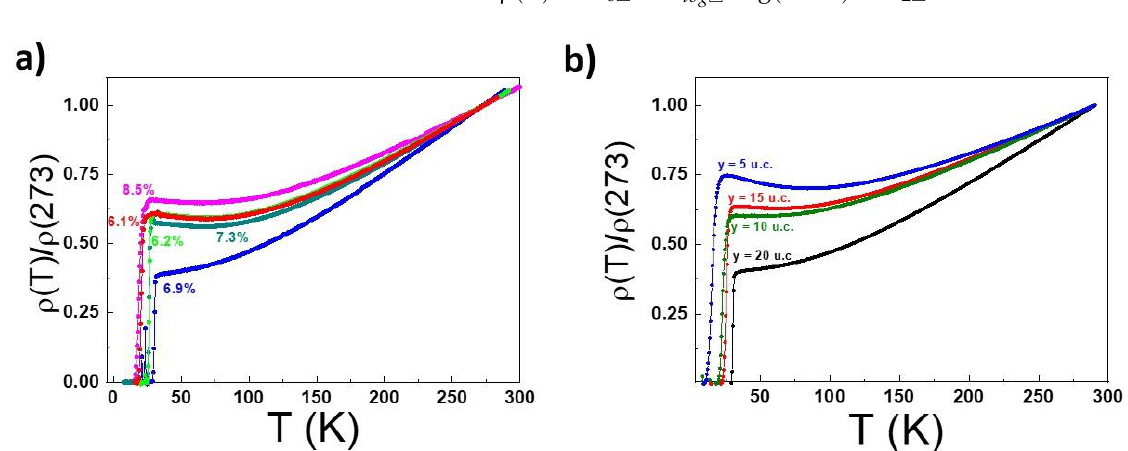
Figure 1. ( a ) Room temperature normalized resistivity vs. temperature ρ (T) curves for SLCO films at different doping levels; ( b ) room temperature normalized resistivity vs. temperature ρ (T) curves for trilayers with different central layer